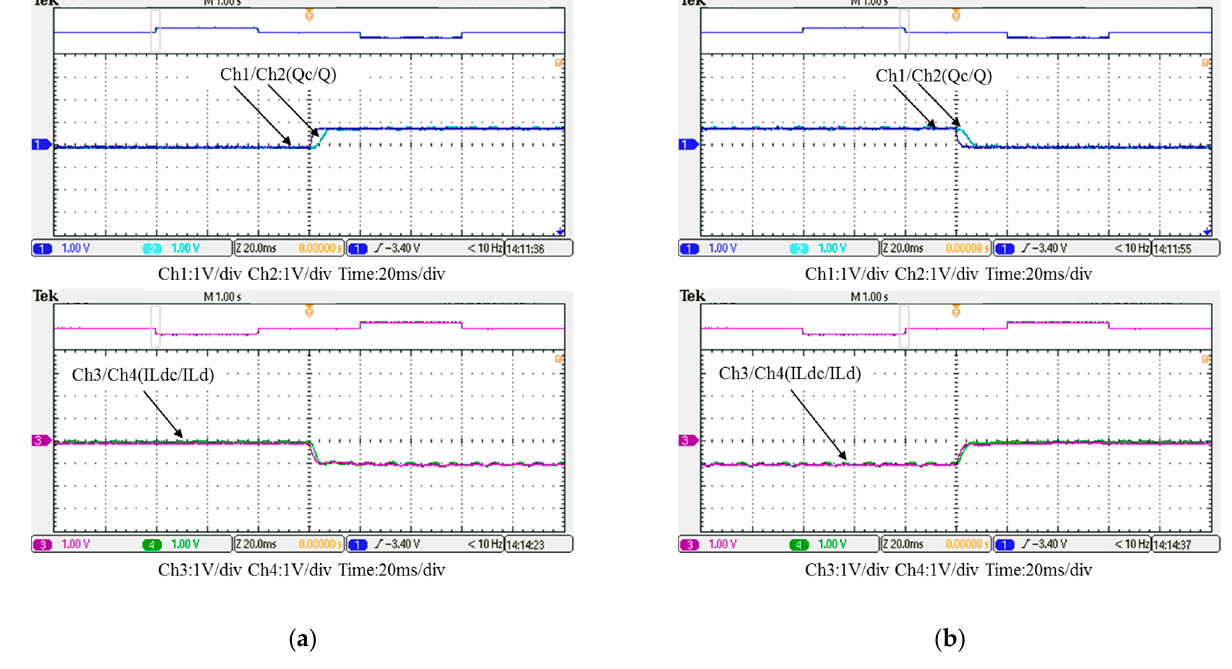
Figure 33. Detailed view of Figure 31: ( a ) near t 1 ; ( b ) near t 2 .